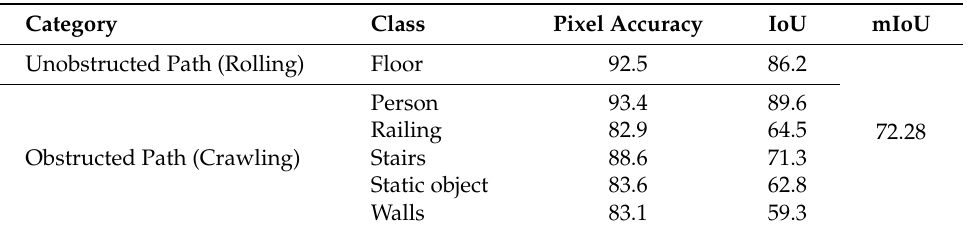
Table 3. Statistical measures for offline locomotion mode